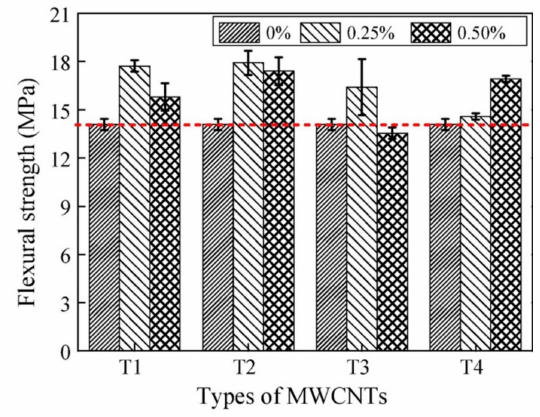
Figure 22. Flexural strengths of the MWCNTs reinforced RPC specimens under water curing. Reprinted with permission from [118]. Copyright © 2018, Elsevier